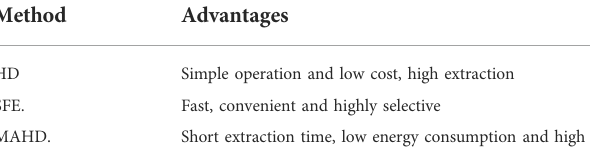
TABLE 1 Advantages and disadvantages of different extraction